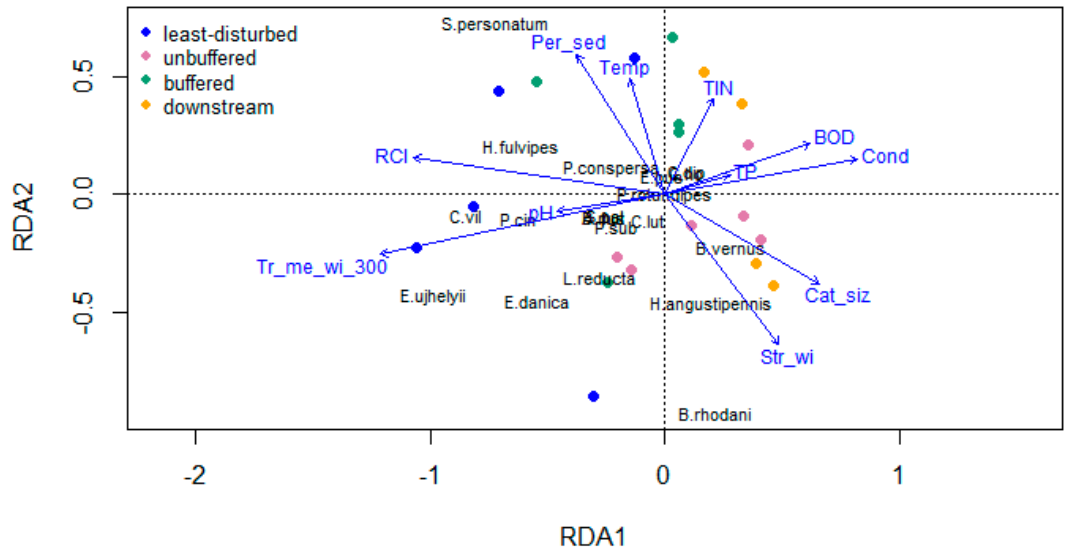
Figure 4. Redundancy analysis (RDA) plots of Ephemeroptera, Plecoptera and Trichoptera (EPT) taxa in response to gradients of environmental variables’ riparian condition index (RCI), forest and shrub mean width at Loc300mUP (Tr_me_wi_300), water pH (pH), water temperature (Temp), percentage of fine sediments (Per_sed), conductivity (Cond), biological oxygen demand (BOD), catchment size (Cat_siz), stream width (Str_wi), total inorganic nitrogen (TIN) and total phosphorus (TP). Dots represent the sites. The EPT taxa are Agapetus fuscipes (A.fus), Baetis muticus (B.mut), Baetis rhodani (B.rhodani), Baetis vernus (B.vernus), Caenis horaria (C.ho), Centroptilum luteolum (C.lut), Chaetopteryx villosa (C.vil), Cloeon dipterum (C.dip), Electrogena ujhelyii (E.ujhelyii), Enoicyla pusilla (E.pus), Ephemera danica (E.danica), Hydropsyche angustipennis (H.angustipennis), Hydropsyche fulvipes (H.fulvipes), Lype reducta (L.reducta), Paraleptophlebia submarginata (P.sub), Plectrocnemia conspersa (P.conspersa), Potamophylax cingulatus (P.cin), Potamophylax rotundipes (P.rotundipes), Sericostoma personatum (S.personatum) and Silo pallipes (S.pal). The environmental variables explain 57.6% of variation in EPT taxa occurrences.